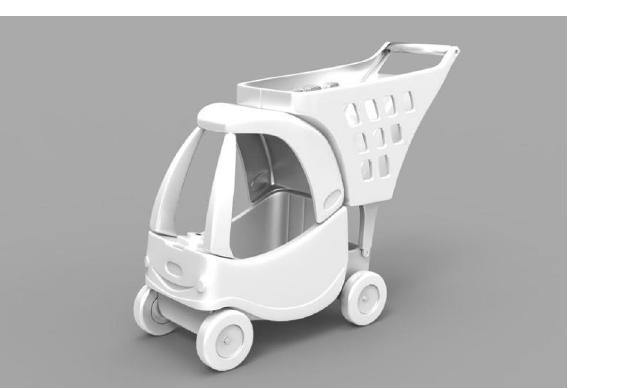
Figure 6. PAW Patrol animation images. © publicly available animated image from the Mango TV platform.